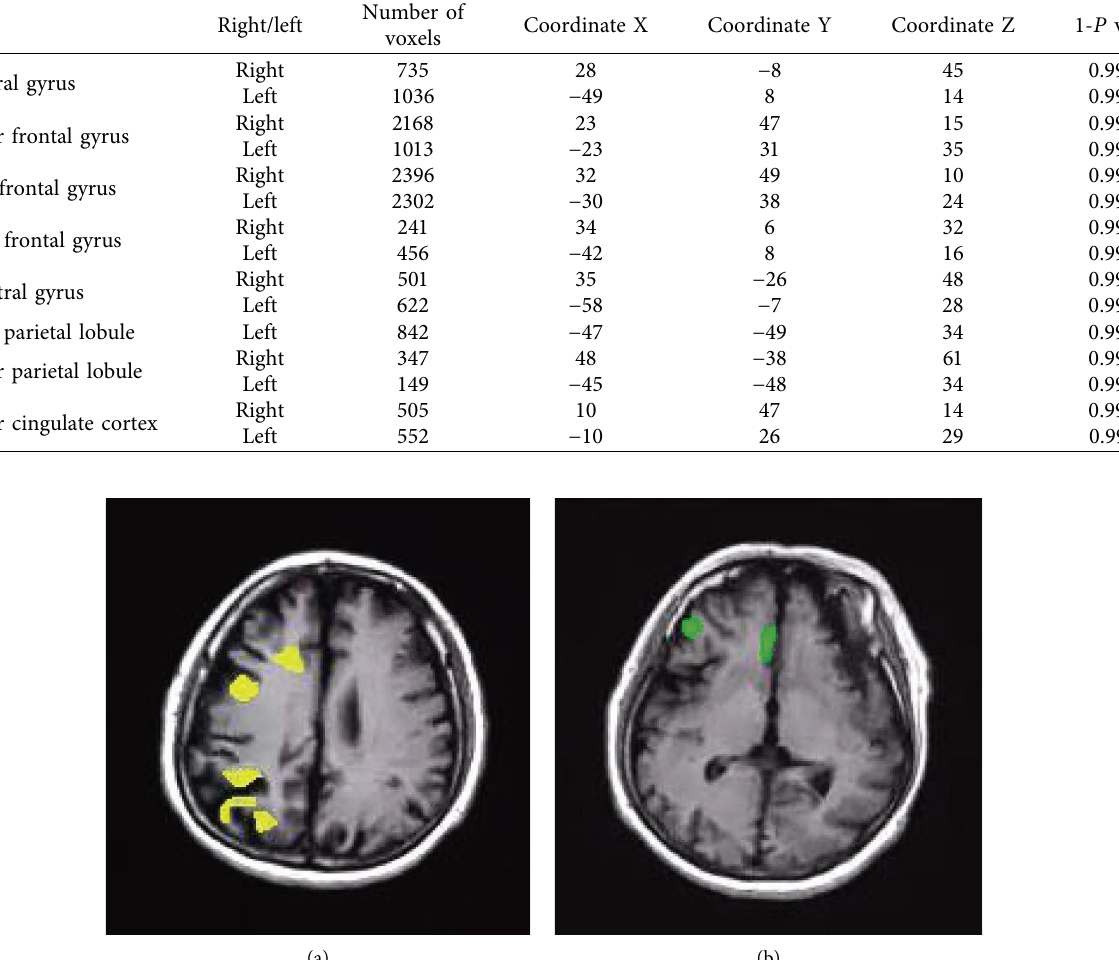
Figure 1: Te results of VBM showed that the gray matter volume of the observation group was reduced compared to the control group. (a, b) MRI T1W1 images of the patients in the observation group. Te yellow area in (a) represented precentral gyrus, superior frontal gyrus, middle frontal gyrus, postcentral gyrus, and superior parietal lobule. Te green area in (b) represented inferior frontal gyrus and anterior cingulate Table 3: Te results of VBM show that the gray matter volume increased in the observation group compared with the control group. Regions